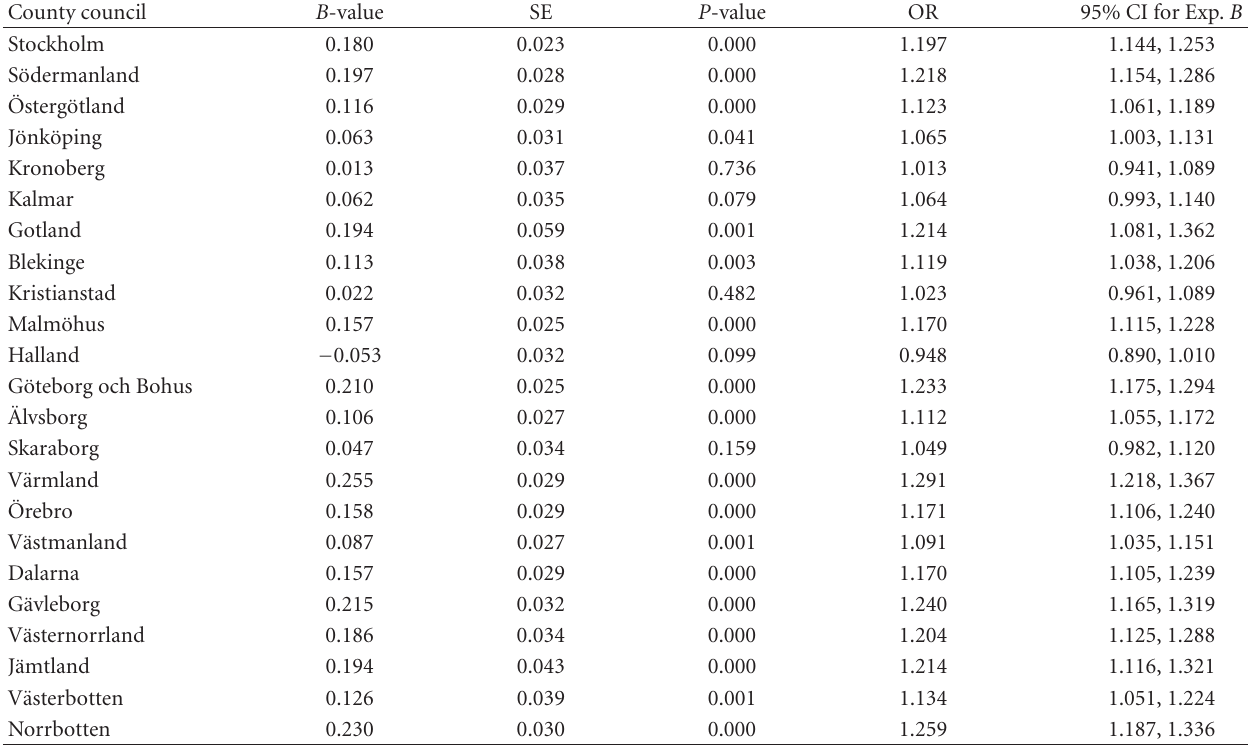
Table 6: Multifactorial influence of being foreign-born on mortality adjusted for age and gender with latest county council of residence as independent categorical variable using Uppsala county council as